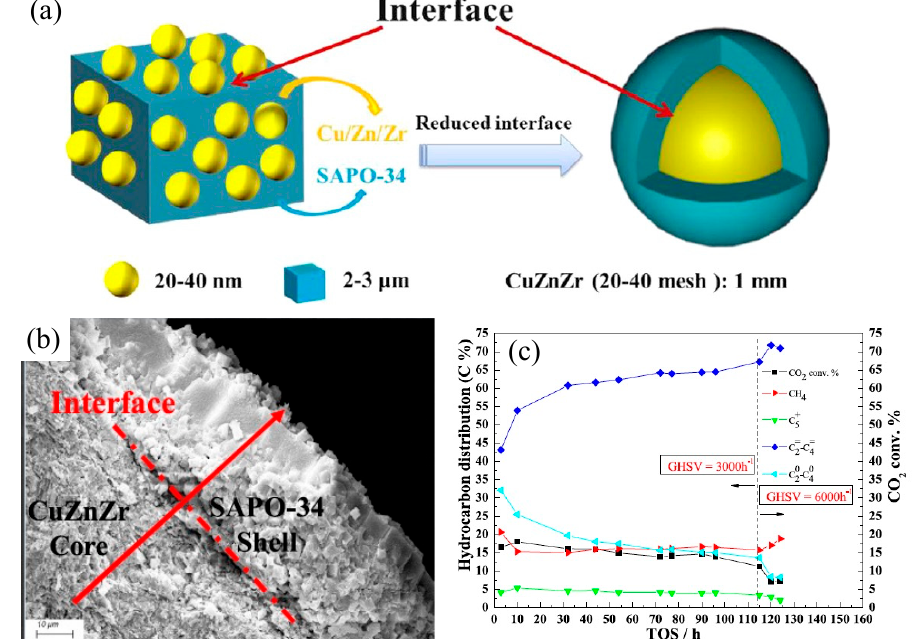
Figure 26. ( a ) Schematic illustration of the interface between CZZ and SAPO-34. ( b ) Core–shell interface of CZZ and SAPO-34. ( c ) Stability of the composite catalyst CZZ@Zn-SAPO-34 at TOS (testing conditions: H 2 /CO 2 molar ratio = 3, T = 673 K). Adapted with permission from ref. [120]. Copyright 2019 Elsevier.